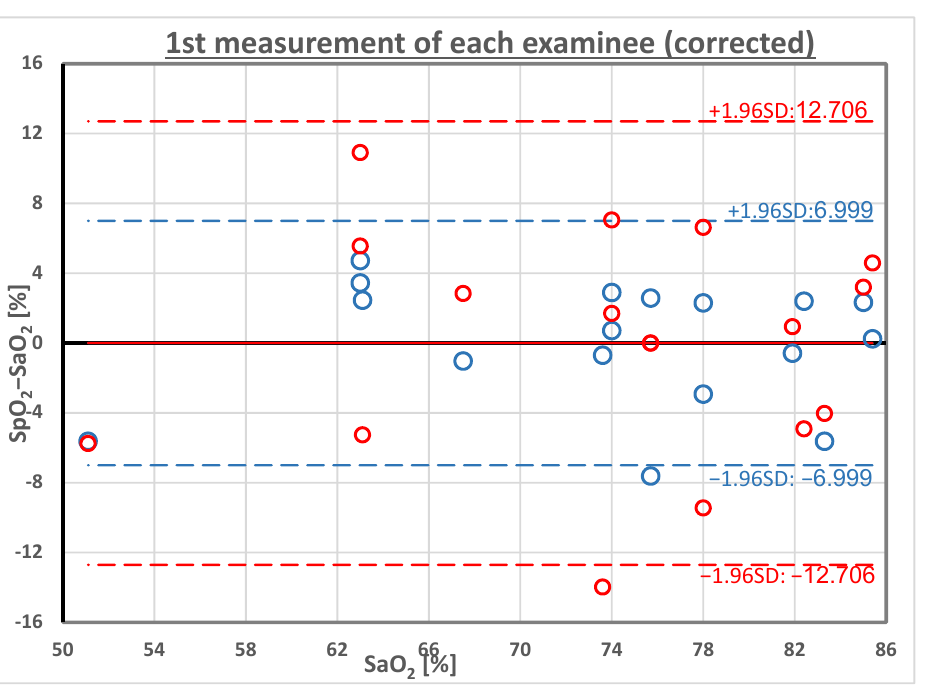
Figure 4. Modified Bland-Altman plot: SpO 2 − SaO 2 as a function of SaO 2 for the two SpO 2 measure- ment techniques. SpO 2 − SaO 2 is small for SaO 2 above 80% but is about 12% for low values of SaO 2 .